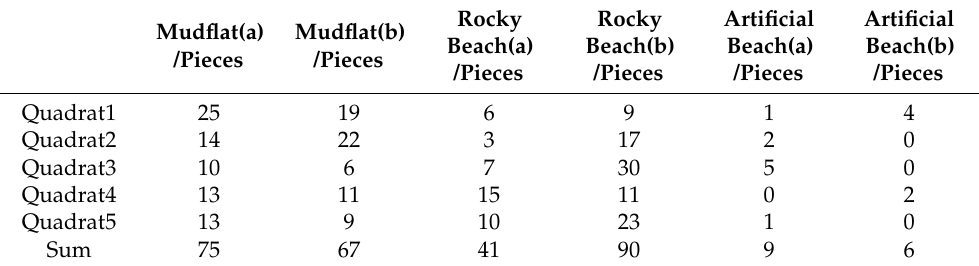
Table 2. Number of samples collected in each quadrat from each